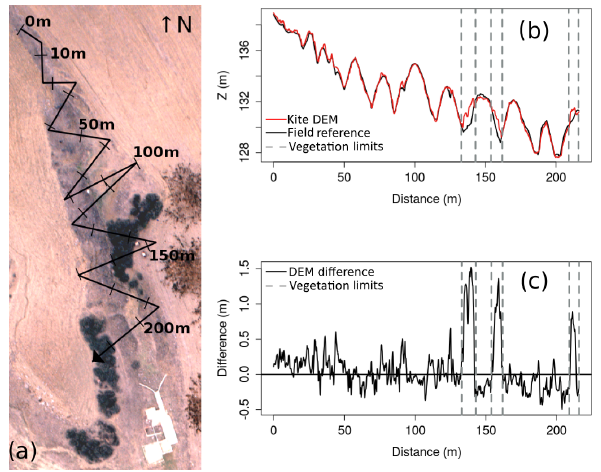
Figure 10. Comparison of the kite DEM with the ground survey. (a) Plan of the gully showing a gauging station at the gully outlet (white), two dense shrub patches of approximately 1m height on the sides of the gully (dark black) and three patches of recent ma- nure application (brown) in the field on the left bank of the gully; the graduated black line shows where profiles have been extracted. (b) Comparison of kite DEM (red) and ground survey (black) pro- files; the vertical dashed lines delimit areas covered with shrubs. (c) Difference between the kite DEM and the ground survey along the same profile. Error statistics computed on this area are reported in Table